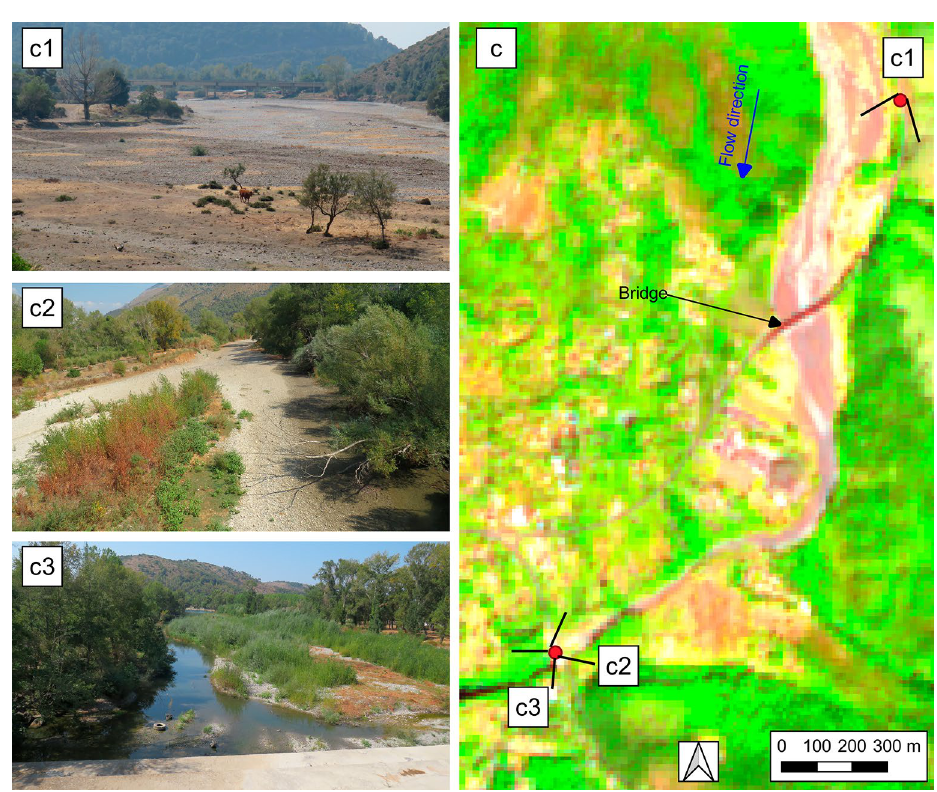
Figure 4. Test case n° 4, M3 reach, ( c ) FCI extracted by Sentinel-2 image of 19 September 2020 with the geolocation points of the photos, ( c1 ), ( c2 ) and ( c3 ) geo-located photos take on 19 September 2020. QGIS 3.10.11 https:// www. qgis. org/ it/ site/ forus ers/ downl oad.